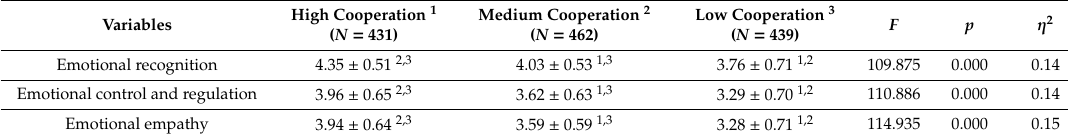
Table 5. ANOVA analysis of di ff erences in emotional intelligence dimensions according to cooperation levels.